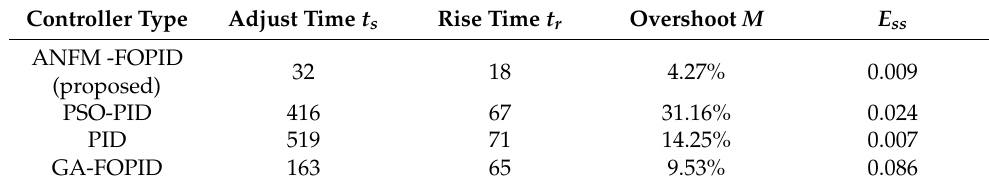
Table 4. Performance of four different